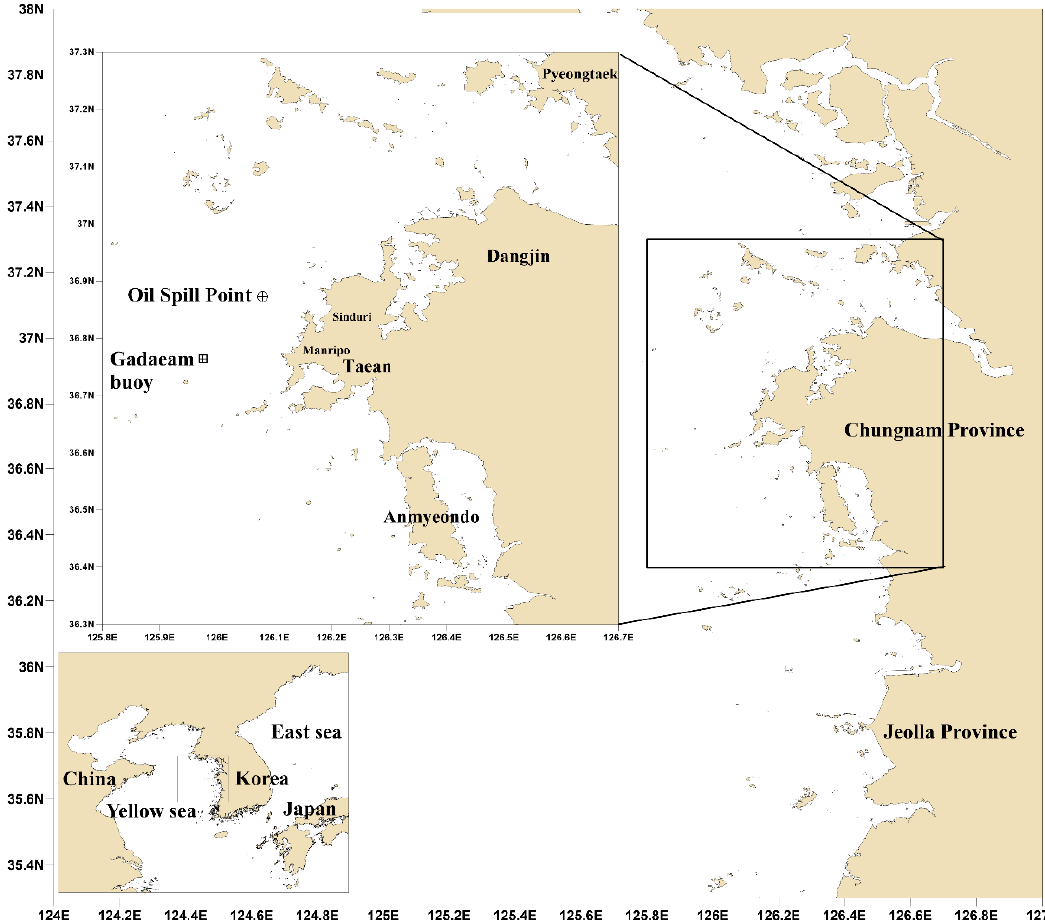
Figure 1. Map of study area. The circle and square symbols indicate the collision point of the Hebei Spirit (126°03.1’N, 36°52.3’E) and the location of the Gadaeam buoy (125°58.36’N, 36°46.12’E).